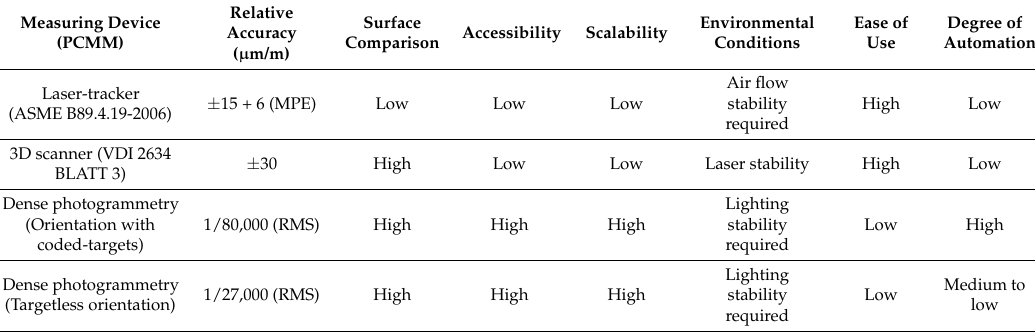
Table 1. Summary and comparison of measuring techniques for casting part verification.